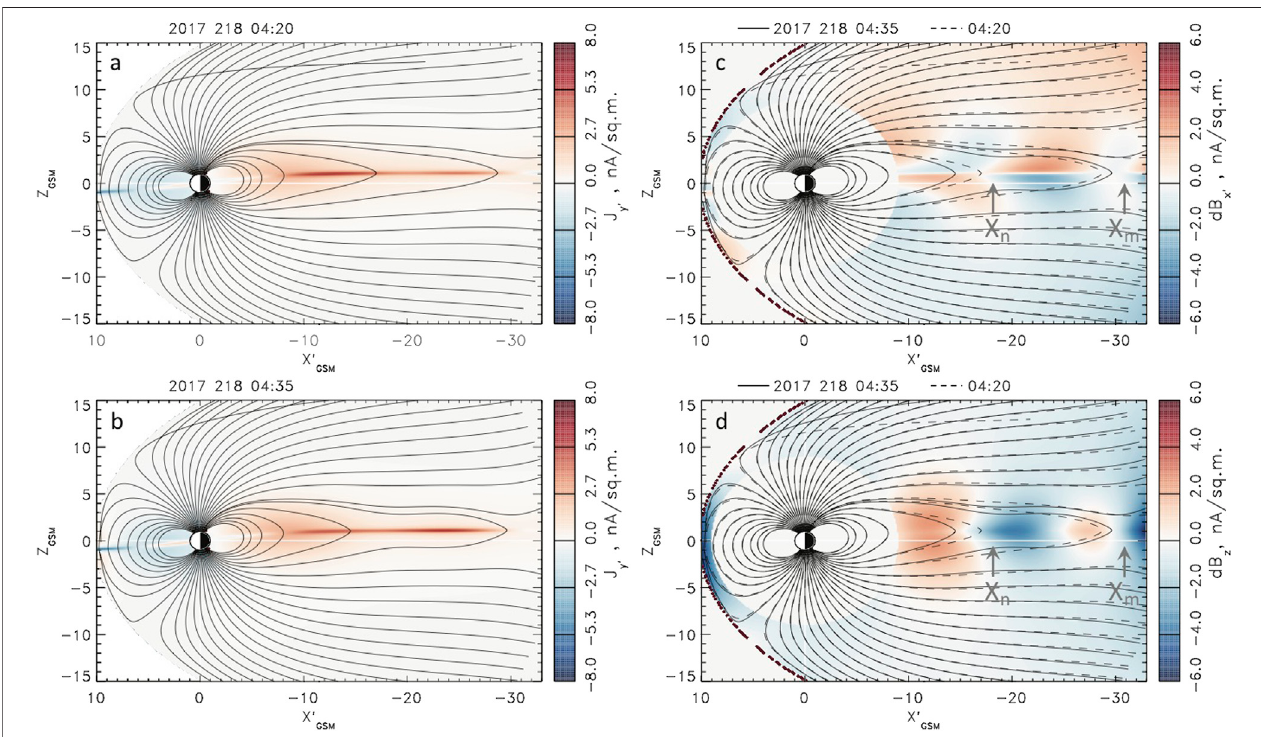
FIGURE 10 | (A, B) Color-coded distributions of the current density component J y ′ normal to the meridional plane shown by the dashed lines in Figure 6 with overplottedmagnetic fi eldlines(blacksolidlines)forthemoments t 0 (cid:1) 04 : 20UTand t 2 (cid:1) 04 : 35UTofthe fi rstdipolarizationduringthe6August2017substorm. (C,D) Color-coded distributions ofthex ’ -and z-components ofthe magnetic fi eldvariationbetweenmoments t 0 (cid:1) 04 : 20UTand t 2 (cid:1) 04 : 35 UT dB x ′ , z (cid:1) B x ′ , z ( t 2 ) − B x ′ , z ( t 0 ) in the same meridional plane with overplotted magnetic fi eld lines (solid lines for the moment t 2 and dashed lines for the moment t 0 ). x ′ GSM is the coordinate along the dashed lines in Figure 6